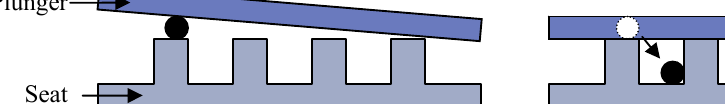
Figure 4. Trapping of particles in grooves etched in a hard